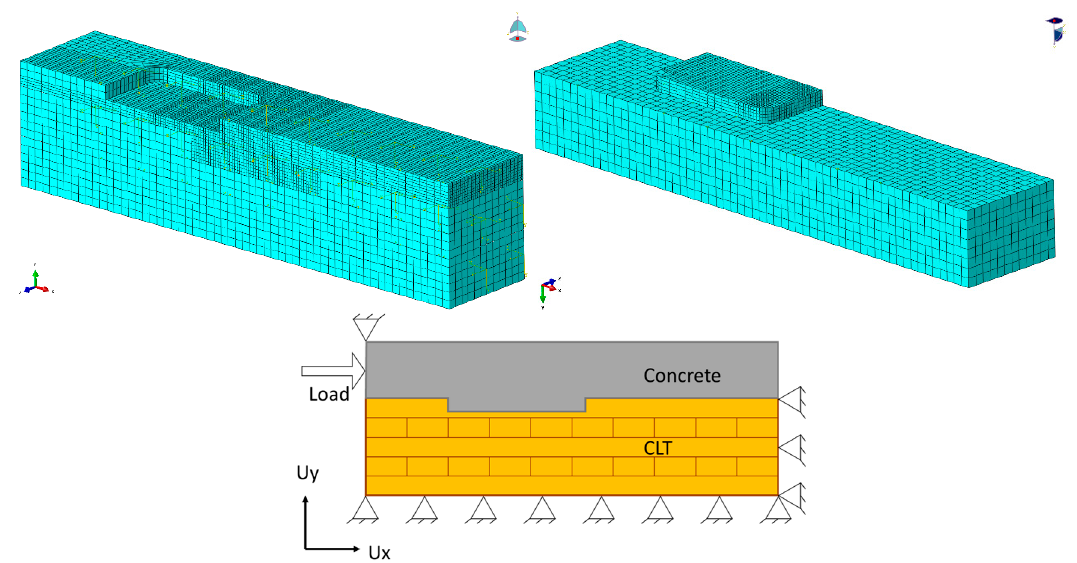
Figure 15. Mesh definition of timber and concrete part and boundary conditions.